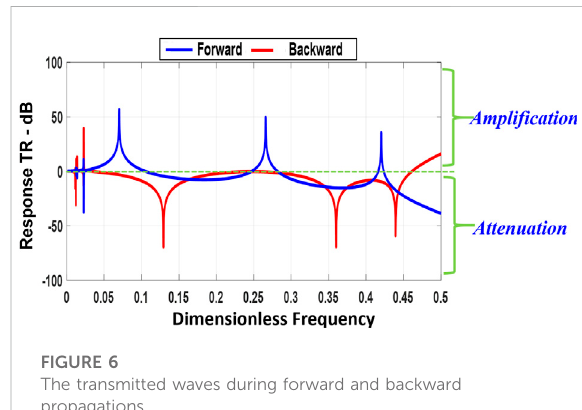
FIGURE 6 The transmitted waves during forward and backward propagations.